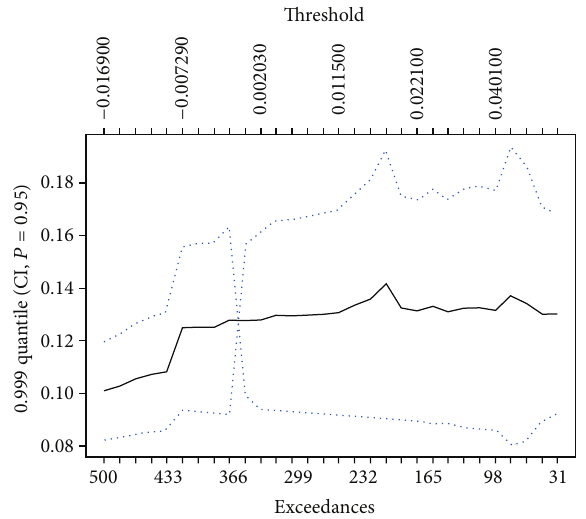
Figure 5: The sensitivity of 99.9% quantile estimates to changes in the threshold.